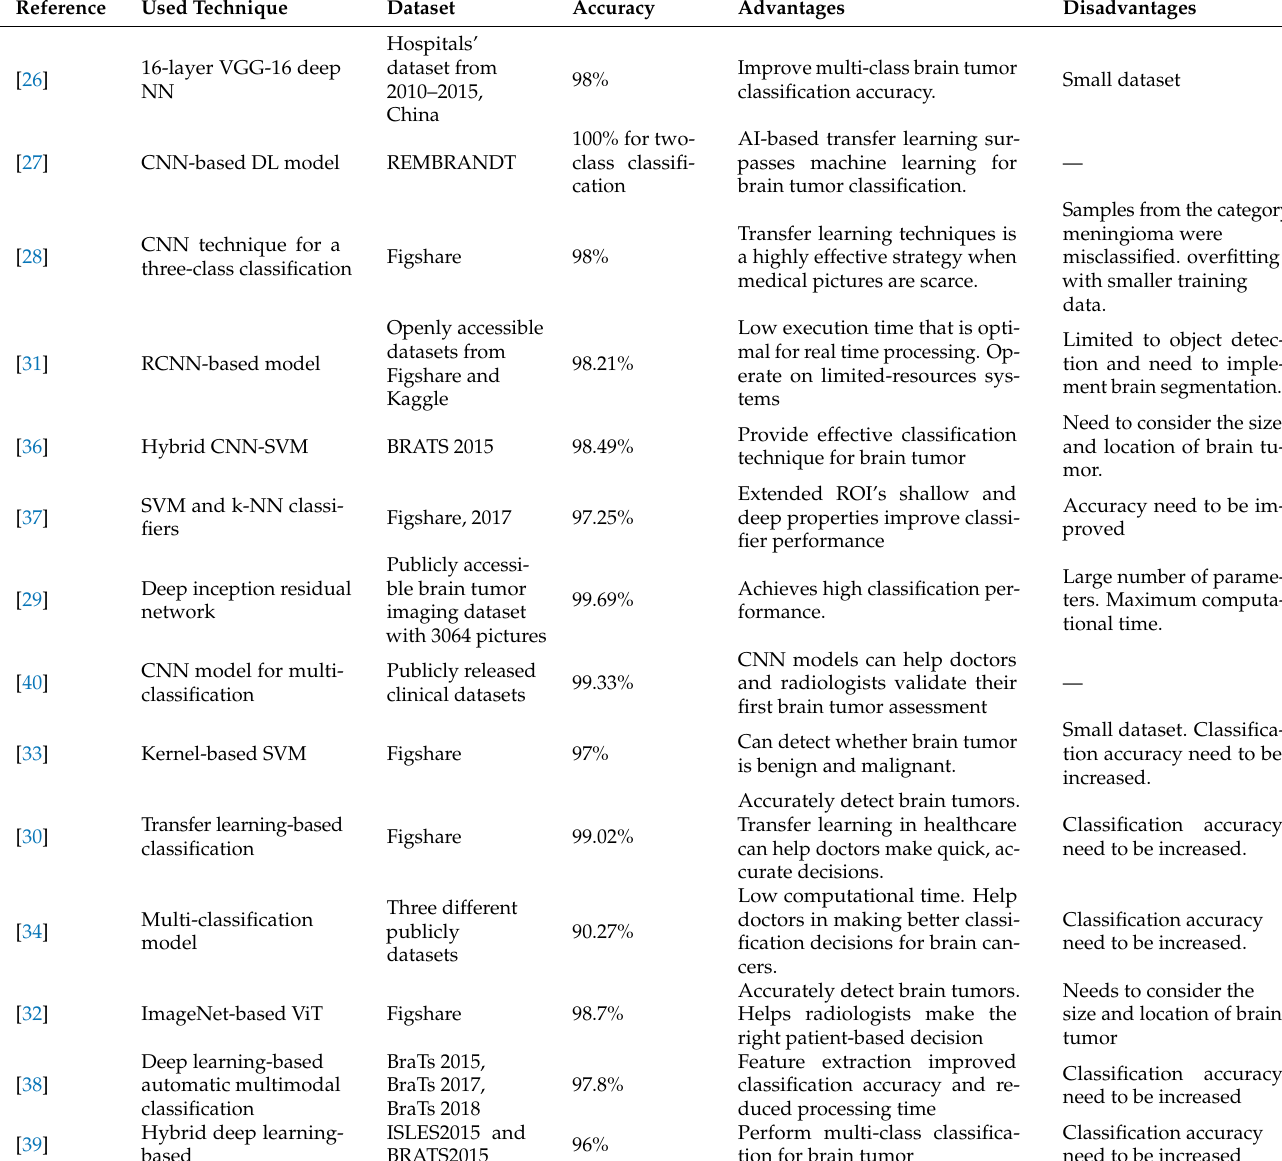
Table 1. Different brain tumor classification